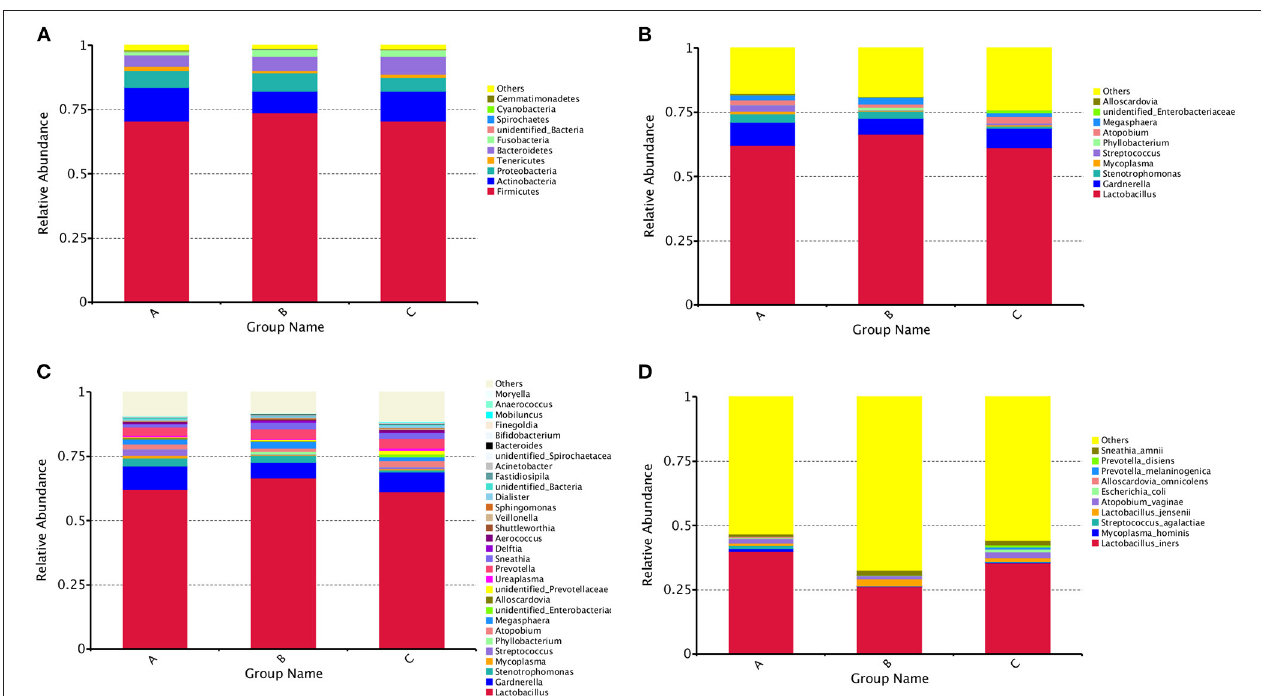
FIGURE 2 | The community composition of vaginal bacterial in three groups. (A) Bar chart of relative abundance of top 10 phyla of each group. (B) Bar chart of relative abundance of top 10 genera of each group. (C) Bar chart of relative abundance of top 30 genera of each group. (D) Bar chart of relative abundance of top 10 species of each